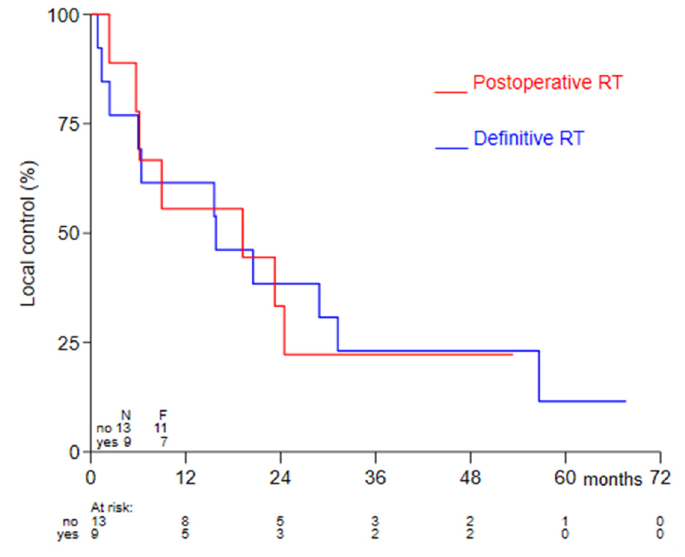
Figure 2. Kaplan-Meier curves for LC were compared for definitive versus postoperative treatment using the log-rank test.